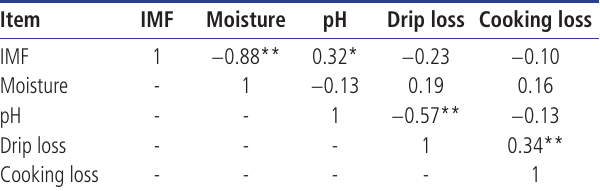
Table 2. Pearson correlation coefficients between IMF, moisture, pH, drip loss and cooking loss of pork Item IMF